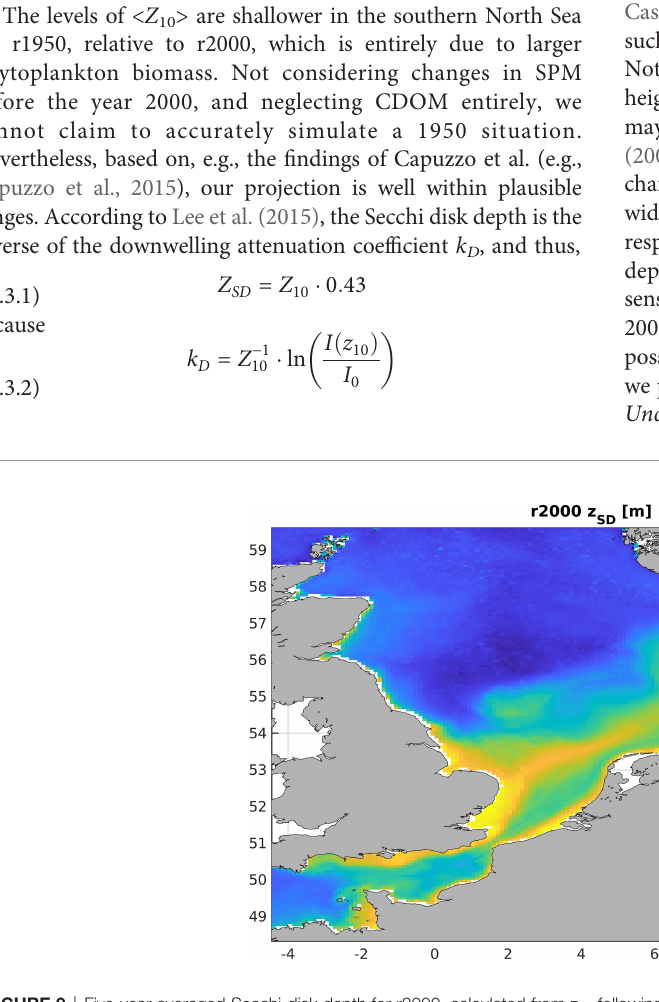
FIGURE 9 | Five-year averaged Secchi-disk depth for r2000, calculated from z 10 following Equation